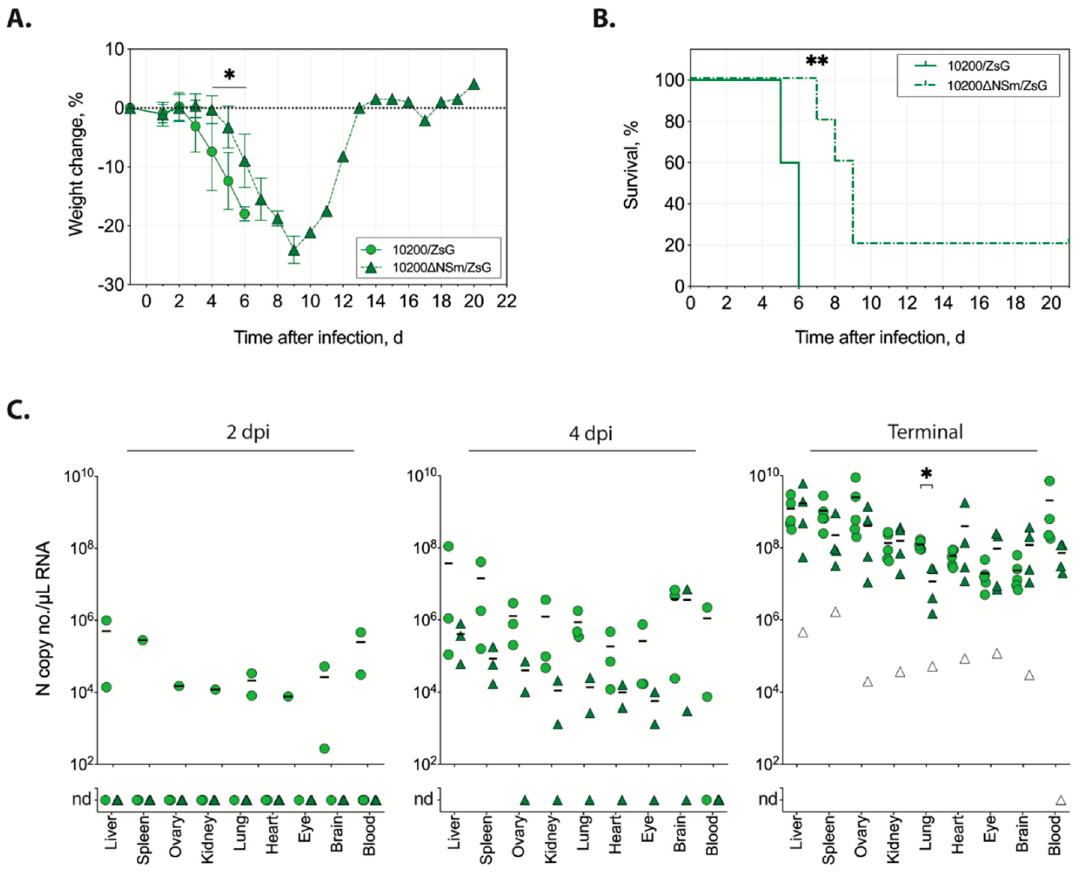
Figure 3. In vivo characterization of recombinant 10200 variants in the Ifnar − / − mouse model. ( A ) Weight change and ( B ) survival of Ifnar - / - mice inoculated subcutaneously with 100 TCID 50 of 10200 / ZsG (green circle and solid line; n = 5) or 10200 ∆ NSm / ZsG (green triangle and dashed line; n = 5). Lines represent the mean weight change of all individuals on that day ± standard deviation (SD). Weight data were analyzed by multiple t -tests; survival statistics were calculated using the Mantel–Cox test; * p < 0.05; ** p < 0.01. ( C ) Viral RNA quantitation at 2 days post infection (dpi; n = 3 each), at 4 dpi (n = 3 each), when euthanasia criteria were met, or at study completion (21 dpi, n = 5 each). Individual animal data are represented for the 10200 N copy number / µ L RNA in each tissue type from mice infected with either 10200 / ZsG (circles) or 10200 ∆ NSm / ZsG (triangles). The single surviving 10200 ∆ NSm / ZsG-infected mouse in the terminal group is represented as a white triangle. Lines represent the mean of positive values. Nd, none detected. Statistics were calculated using multiple t -tests; * p <